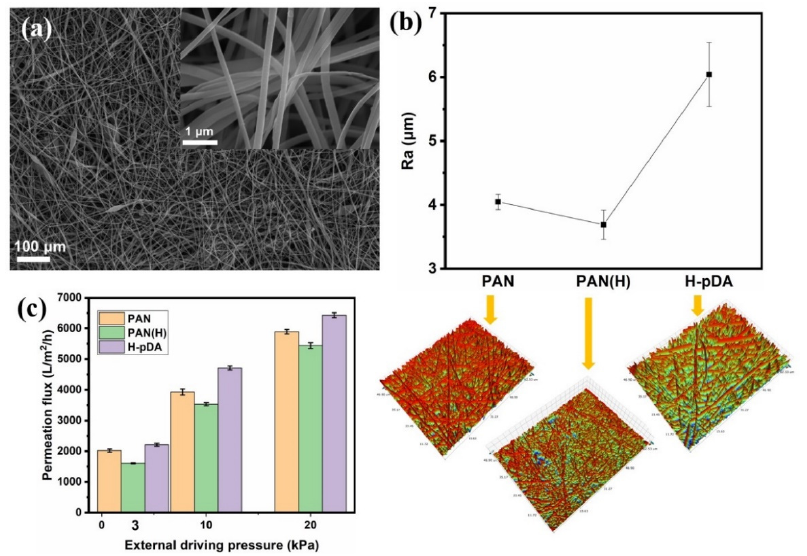
Figure 2. ( a ) SEM image of the PAN membrane treated with sodium hydroxide solution for 4 h. The inset is a high-magnification SEM image of the fiber surface. ( b ) Ra values of the membranes (PAN, PAN after hydrolyzation for 4h, and hydrolyzed PAN after 20 h of PDA treatment.). There are noncontact optical profiler imagers, respectively, underneath the graph. ( c ) Pure-water flux of PAN, PAN-H, and H-PDA at different external driving pressure.